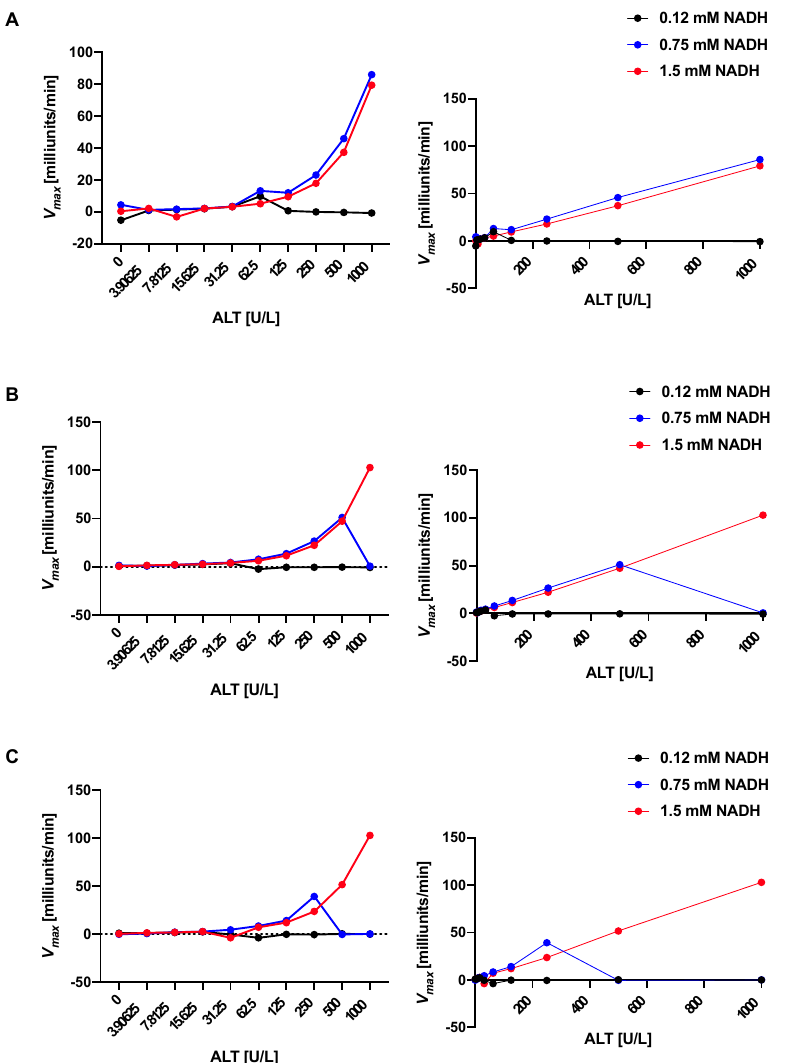
Figure 1. Higher concentration of reduced nicotinamide adenine dinucleotide (NADH) in alanine aminotransferase (ALT) reagent confers stability of standard curve. ALT reagent with low NADH concentration (0.12 mM, black), intermediate NADH concentration (0.75 mM, blue), and high NADH concentration (1.5 mM, red). ( A ) First run. Left, curve with Log 2 scale on X -axis allowing detailed view of lower ALT values; right, linear scale on X -axis demonstrating linear correlation of values with high NADH ALT reagent. ( B ) Second run. Left, curve with Log 2 scale on X -axis allowing detailed view of lower ALT values; right, linear scale on X -axis demonstrating linear correlation of values with high NADH ALT reagent. ( C ) Third run. Left, curve with Log 2 scale on X -axis allowing detailed view of lower ALT values; right, linear scale on X -axis demonstrating linear correlation of values with high NADH ALT reagent. V max , maximum reaction velocity.